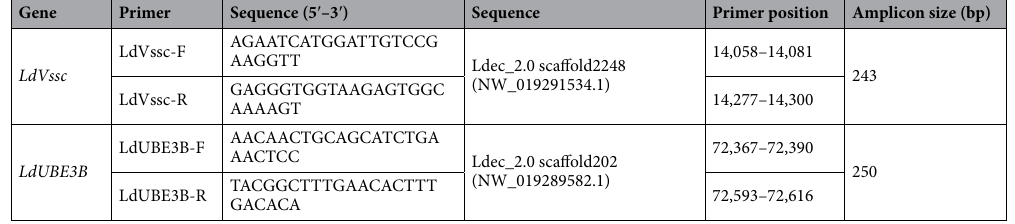
Table 1. Markers designed for CNV-based sex identification system in